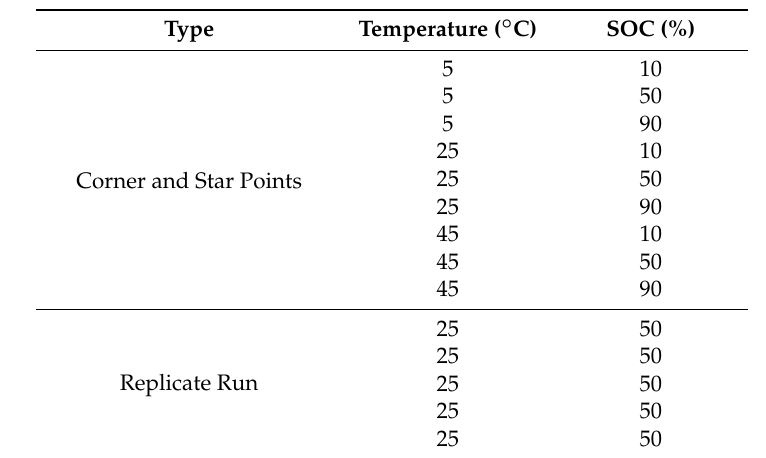
Table 2. Experimentally designed conditions for the HPPC test used in developing the ECM parameter